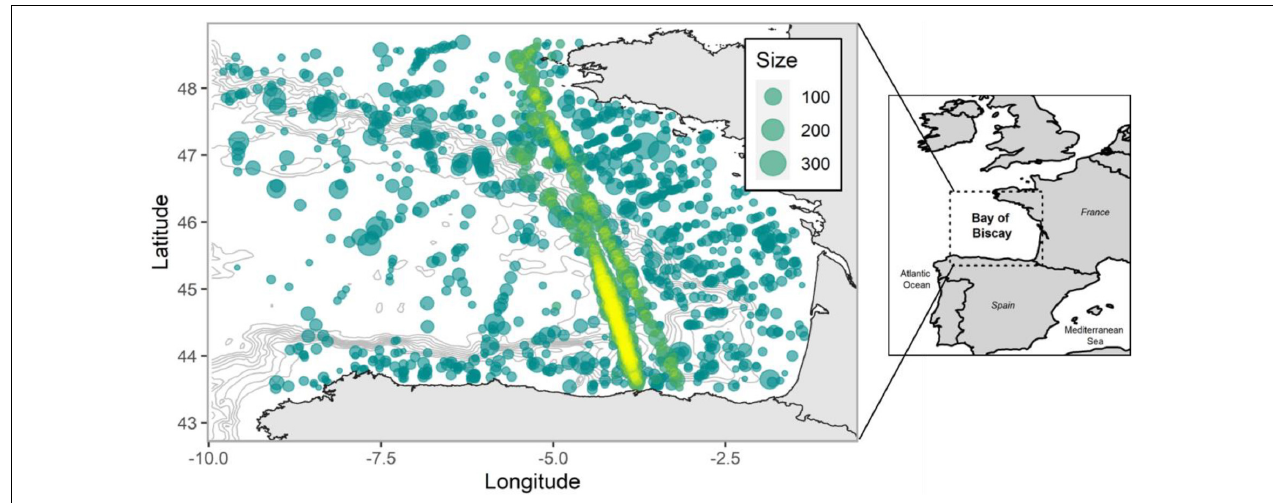
FIGURE 1 | Spatial distribution of common dolphin sightings (displayed in segments of up to 10 km) over the BoB for the 1994–2018 period. Circle sizes are proportional to group size, while solid gray lines indicate the isobaths. Sightings in yellow represent the ferry data used to check model